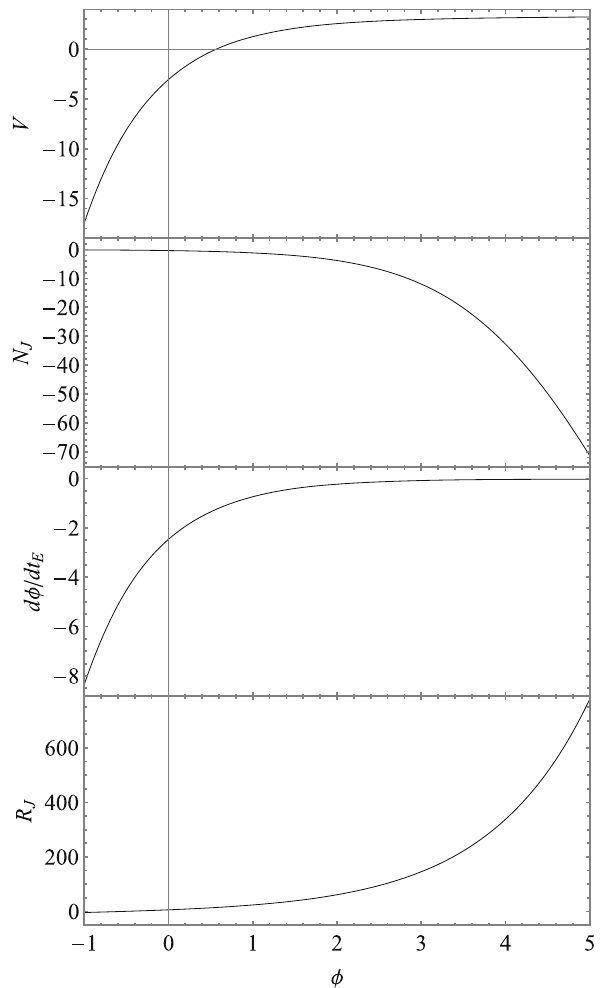
Fig. 1 The potential (20) in the Einstein frame, the phase diagram for the scalaron, the e-folds (35) and the Ricci curvature (26) in the Jordan frame for β = − 0 . 02 ,γ = − 1, where we set M Pl = M =